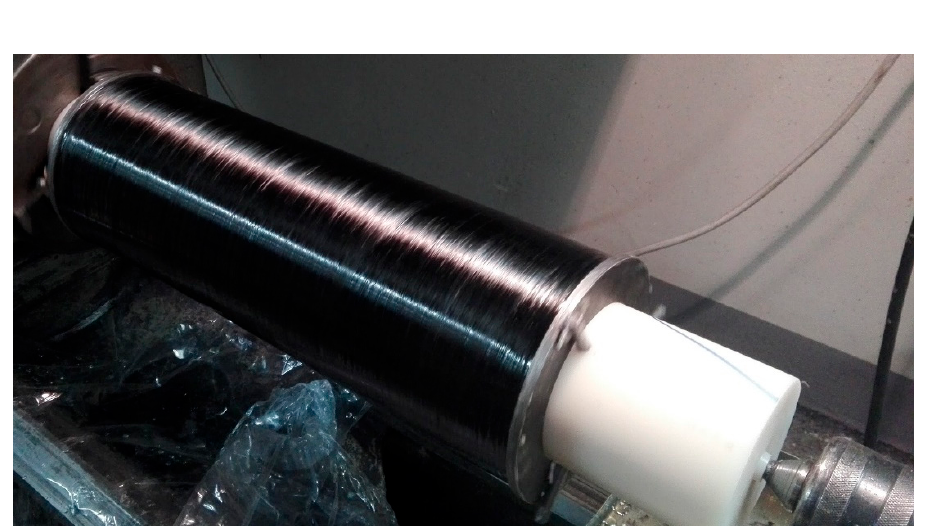
Figure 2. Filament wound cylinder subjected to the experimental